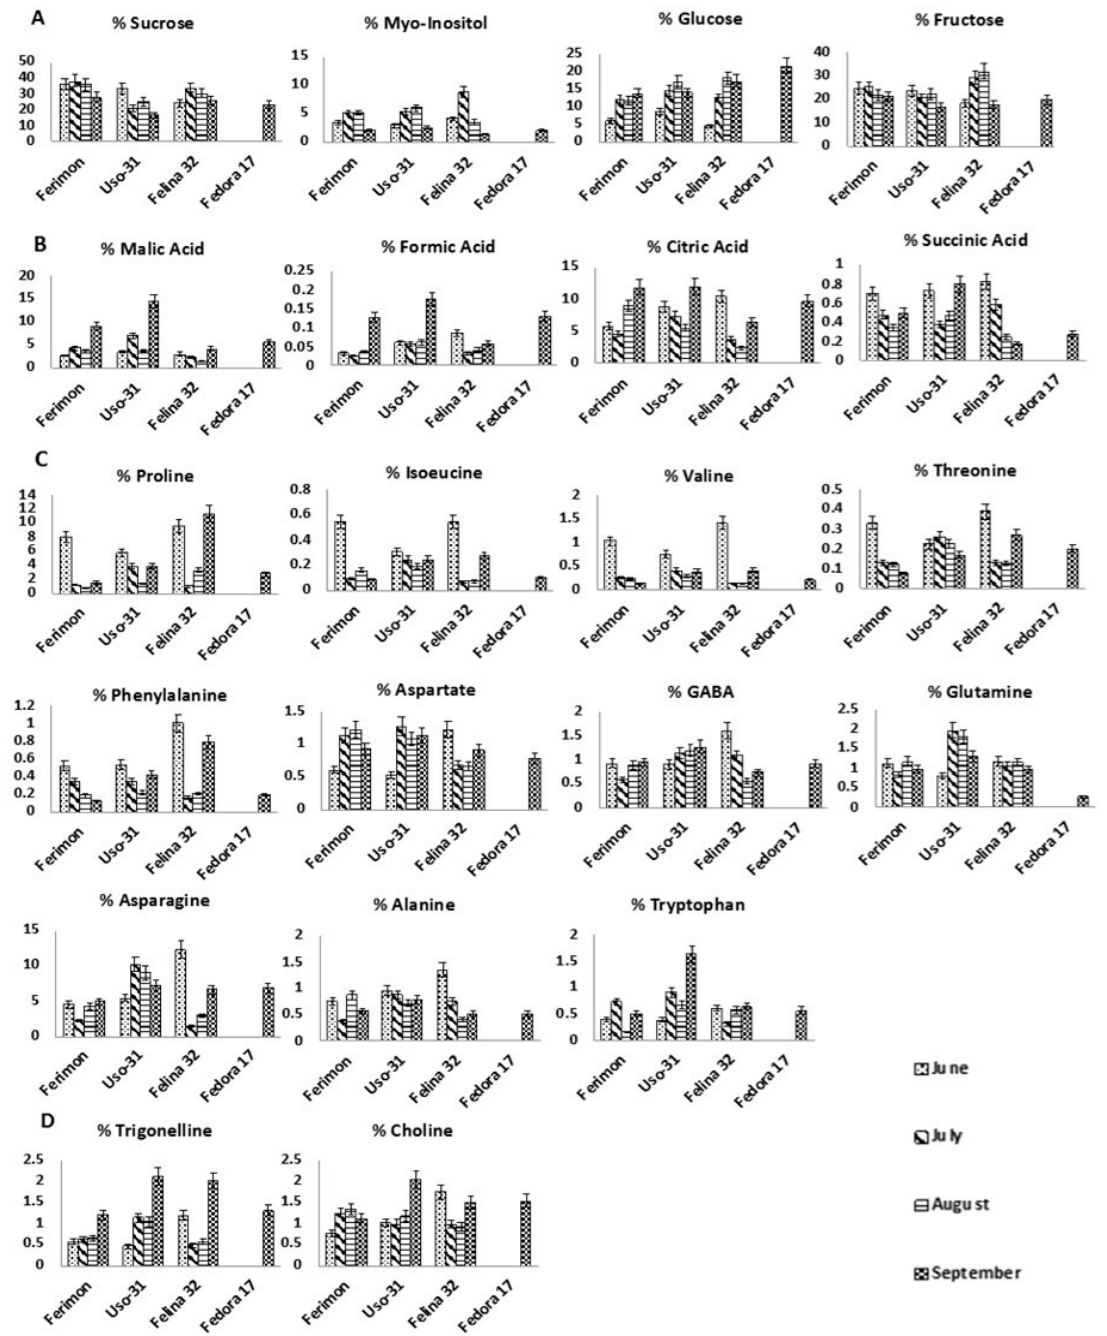
Figure 3. Histograms resulting from the quantitative NMR spectroscopic analysis of some metabolites present in the Bligh-Dyer hydroalcoholic extracts of hemp inflorescences. ( A) . Sugars; ( B) . Organic acids; ( C) . Amino acids; ( D). Other